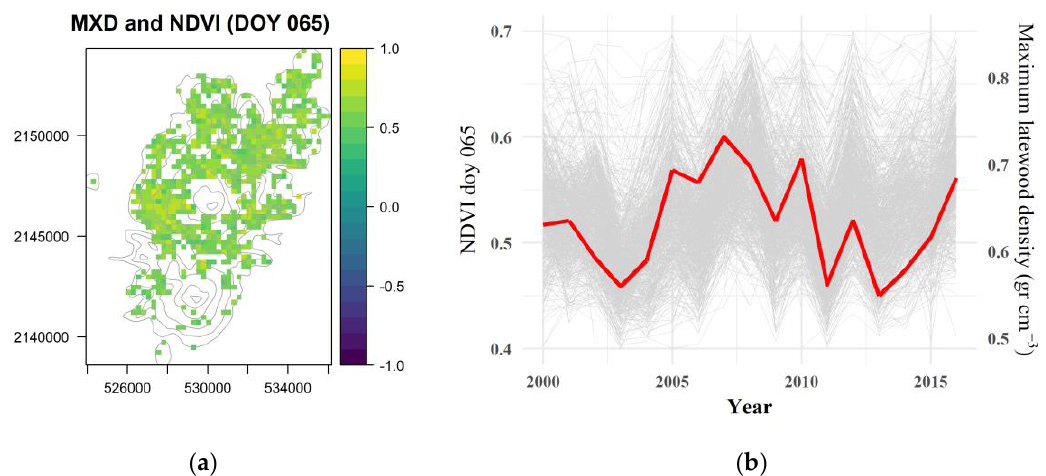
Figure 8. ( a ) Example of the highest spatial correlation ( p < 0.05) between the maximum latewood density—MXD time series and the Normalized Difference Vegetation Index—NDVI on the day of the year 065 at Tláloc mountain (TLA). Gray lines are contour-lines at 100-m intervals starting at 3500 m asl. ( b ) Temporal profile of significant NDVI pixels from the left panel (grey lines) with the MXD average chronology (red line).